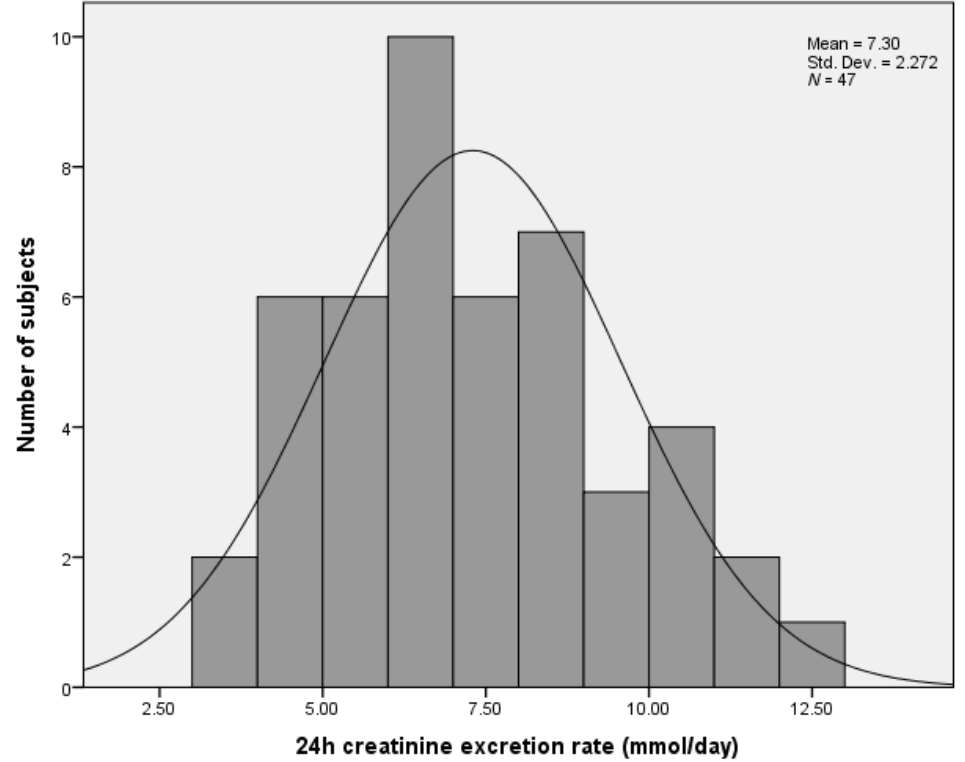
Figure 2. Number of retirement home residents relative to their 24 h urinary creatinine excretion values.